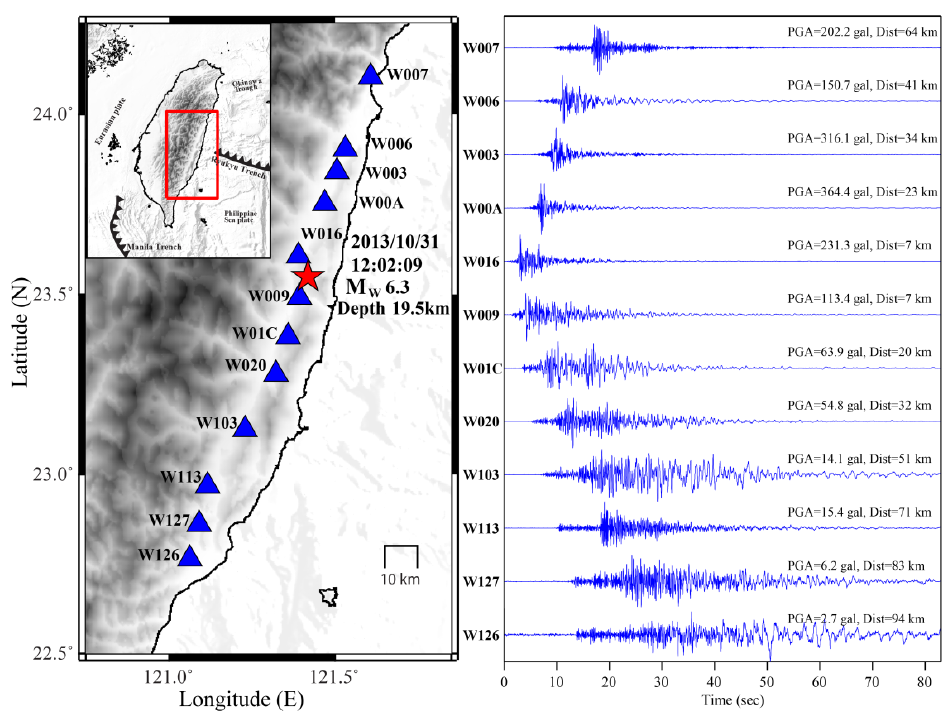
Figure 7. Evaluated fault rupture direction using the recorded waveforms during the 2013 Hualien earthquake. The rupture direction agrees with the aftershock distribution.